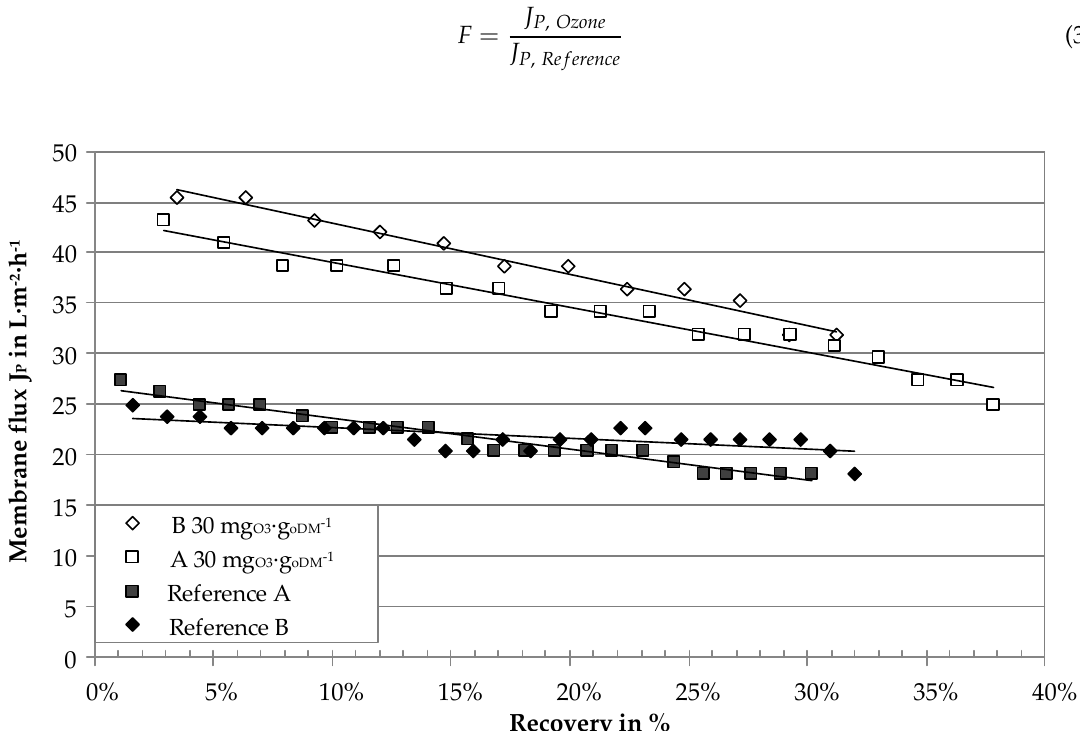
Figure 6. Membrane flux (laboratory ultrafiltration rig) of digestate centrates of two agricultural biogas plants with ozone treatment and without (reference) as a function of recovery, ∆ p = 1.15 ± 0.01 bar, v = 2.46 ± 0.08 m · s − 1 , T = 47.7 ± 1.4 °C